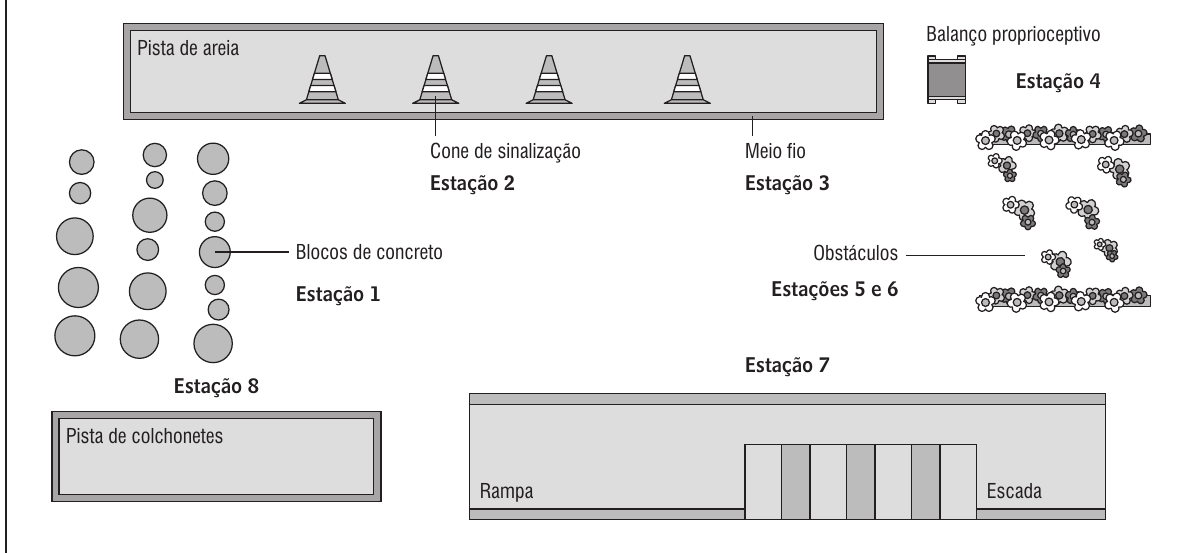
Figura 1 - Esquematização do circuito Fonte: Elaboração dos